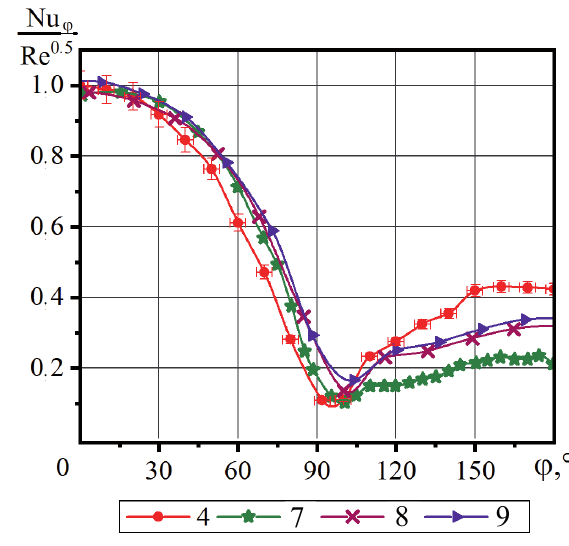
Figure 8. Distribution of the local Nusselt number over the cylinder surface: 4—our data; 7—data by Nakamura and Igarashi [3]; 8 and 9—data by Arpan Sircar et al. [12] (fluid properties taken at the flow temperature and at the average temperature of the flow and cylinder